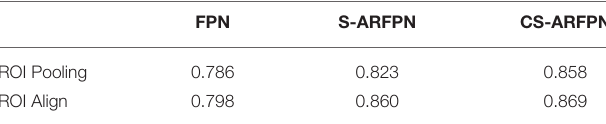
TABLE 6 | Comparison of the precision of ROI pooling and ROI align methods. FPN S-ARFPN ROI